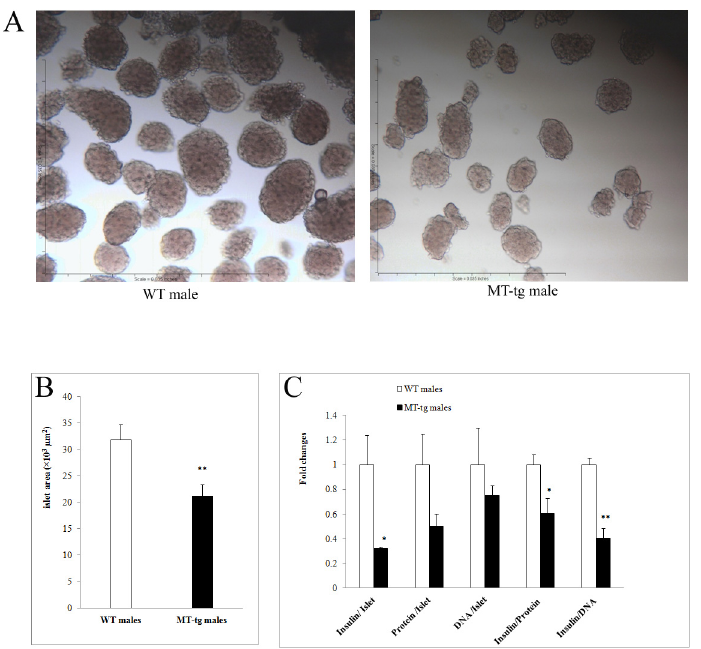
Fig 5. Islet morphology, size, DNA, protein and insulin contents in 8-week-old MT-tg and WT male mice. (A) represents images of islet under a microscope; (B) quantified islet size; (C) islet DNA, protein and insulin contents. * p < 0.05, ** p < 0.001 vs